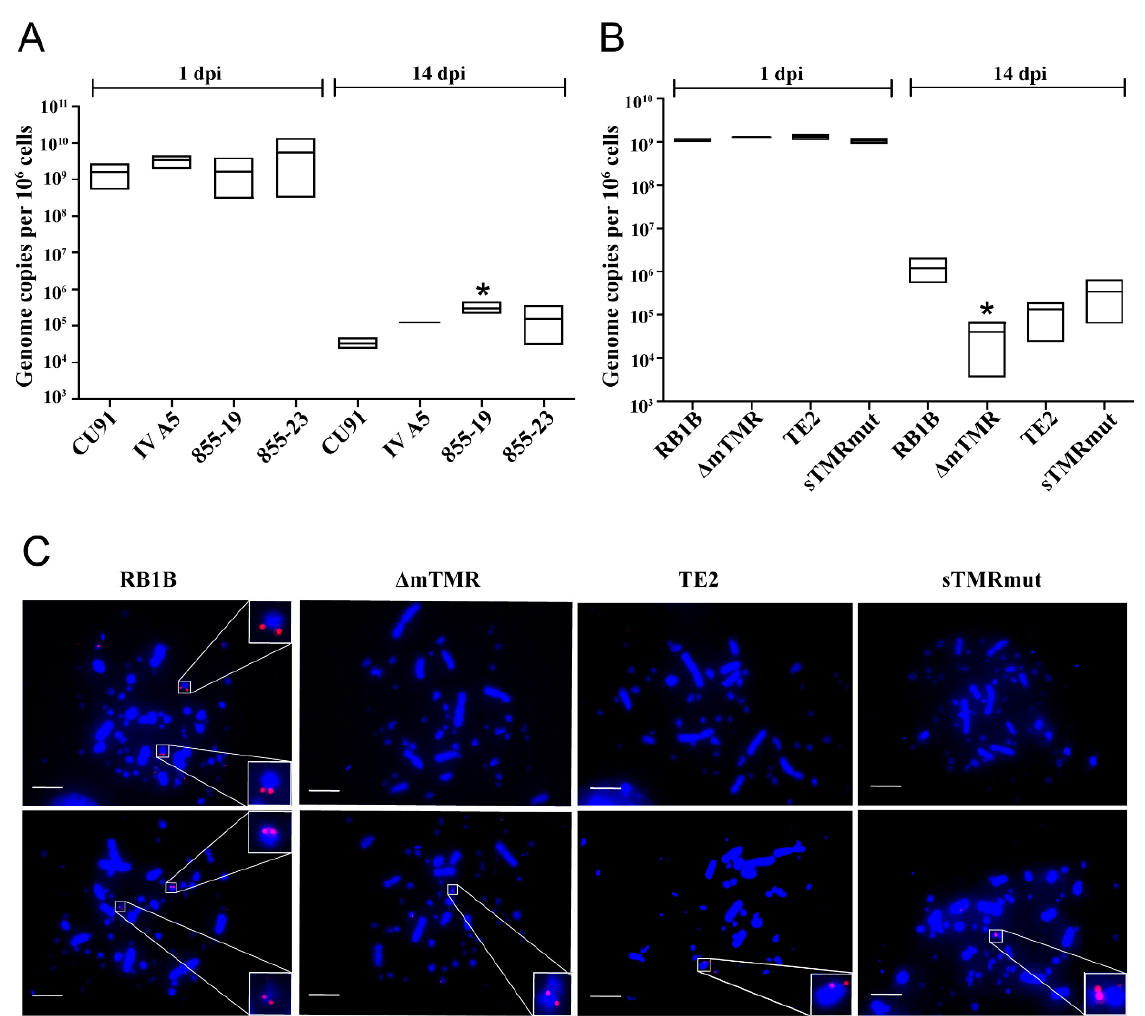
Figure 3. Genome maintenance and integration of the wt and mutant virus in T cells. ( A ) Evaluation of RB1B genome maintenance in different T cell lines. Mean viral genome copies per million cells are shown as box plots with the minimum and maximum. An asterisk indicates significant differences compared to CU91 T cell infections (* p < 0.05, Kruskal–Wallis test, n = 3). ( B ) Comparison of virus maintenance after 855-19 T cell infection with the indicated viruses. Significant differences are in comparison to RB1B (* p < 0.05, Kruskal–Wallis test, n = 3). ( C ) Representative metaphase chromosomes (DAPI stain, blue) are shown along with the presence and location of integrated MDV (Cy3 streptavidin, red) in 855-19 infections with RB1B wild-type and different TMR mutants as indicated. Two representative images per infection are shown. Scale bars correspond to 10 µm.